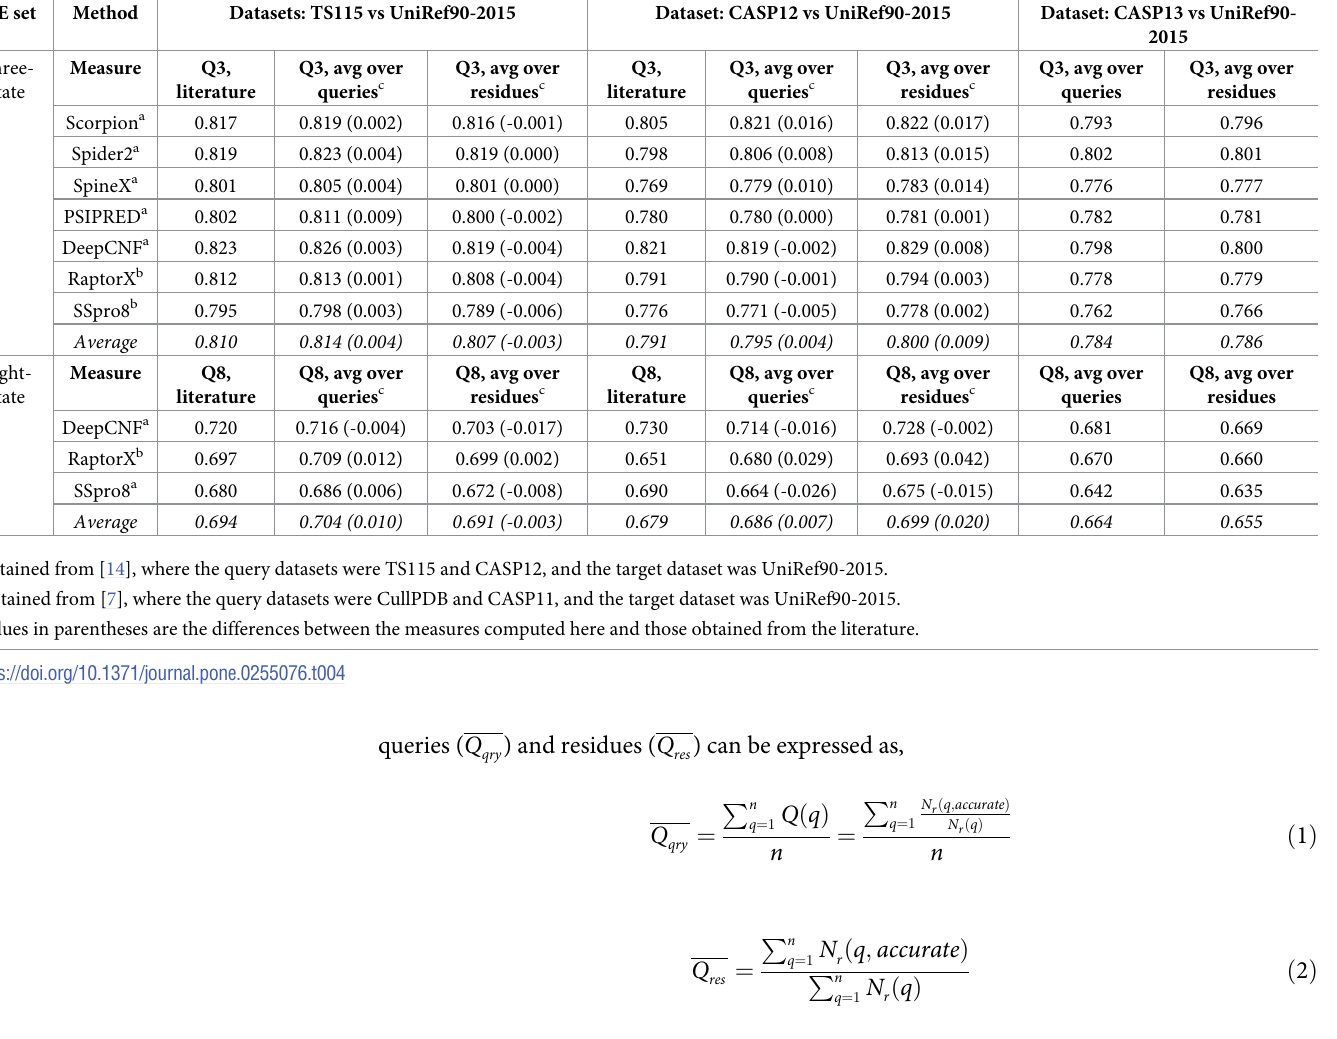
Table 4. Results of performance pretest for several state-of-the-art SSP methods. SSE set